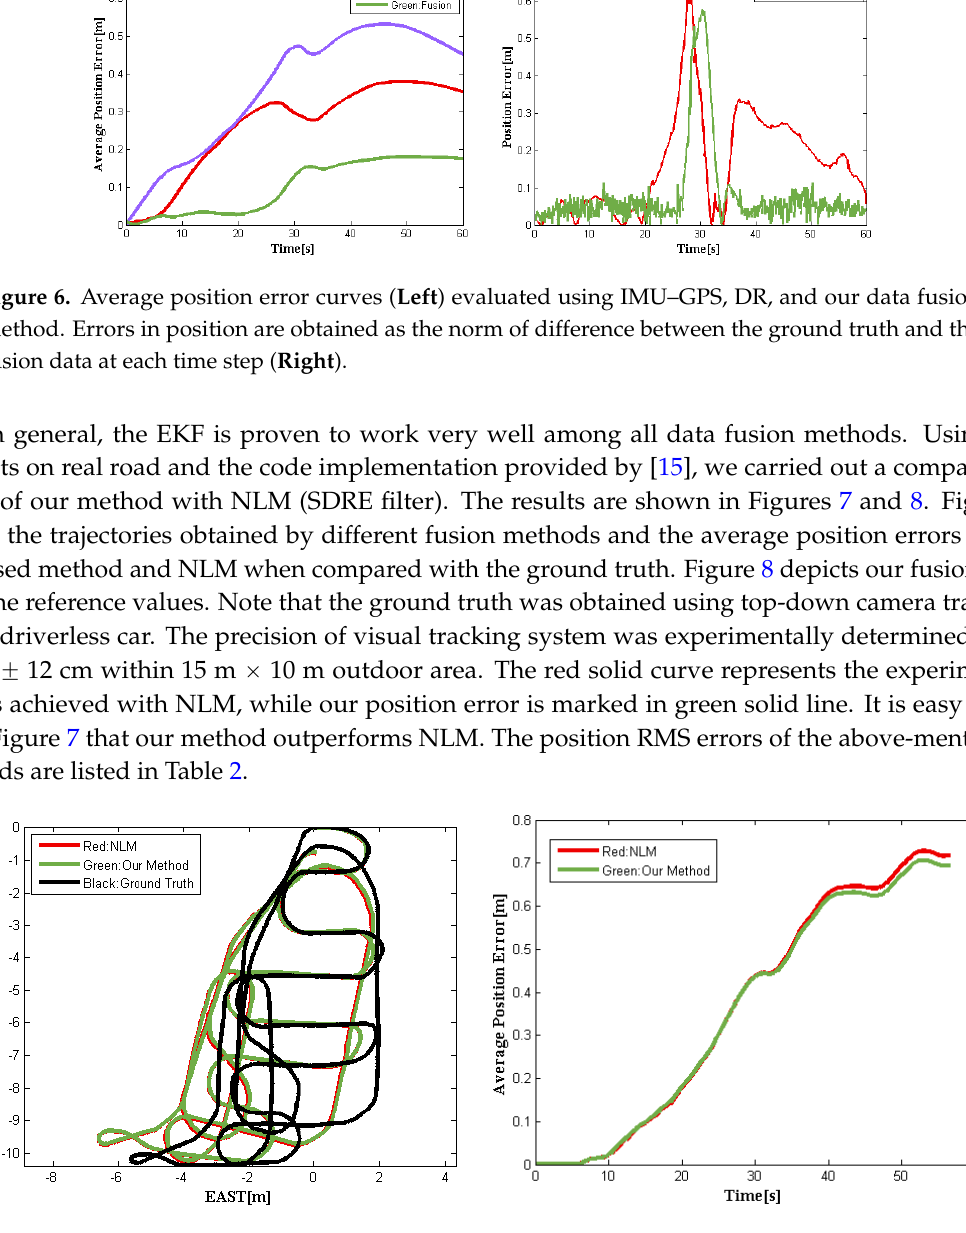
Figure 7. Trajectories obtained by our method and with NLM [15] ( Left ). The evolving of average position errors over time ( Right ).